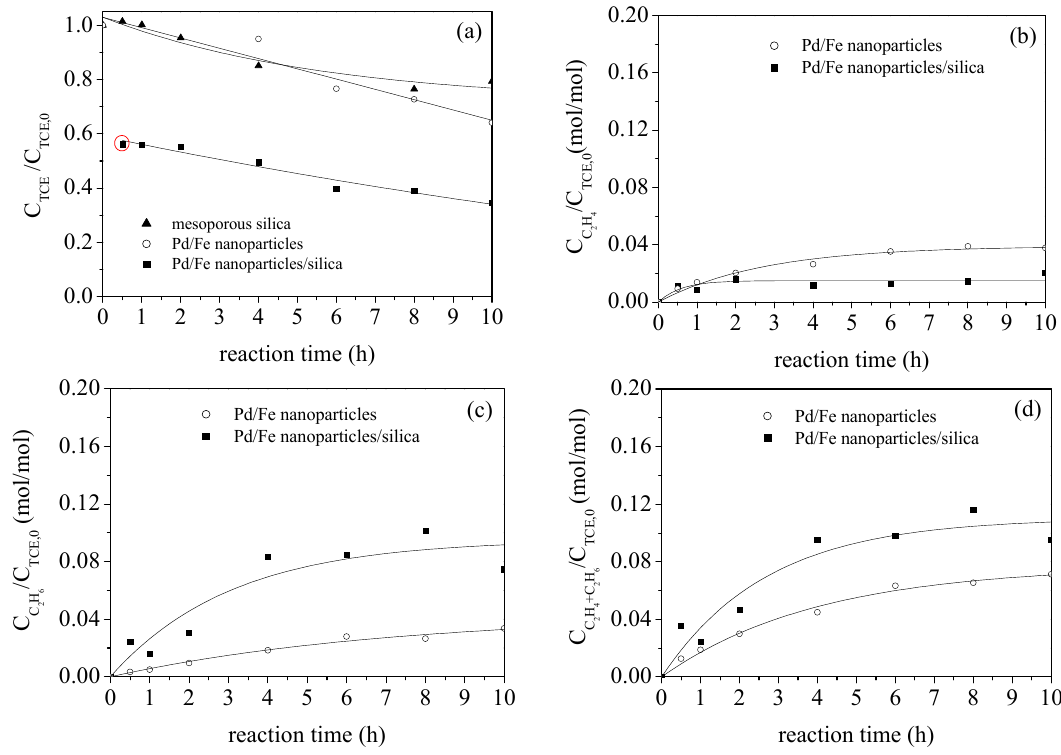
Figure 4. Degradation of trichloroethylene ( a ), and production of ethylene ( b ), ethane ( c ) and ethylene plus ethane ( d ) on bare Pd/Fe nanoparticles and Pd/Fe nanoparticles supported on mesoporous silica with a same weight percentage of Pd to Fe at 0.075%, also shown in ( a ) is trichloroethylene degradation on mesoporous silica. TCE refers to trichloroethylene and silica refers to mesoporous silica. C TCE,0 = 23.7 mg/L (0.181 mmol/L), iron loading = 203 mg/L (3.63 mmol/L), and for the